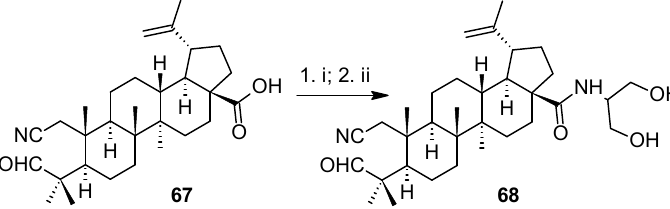
Figure 3. Ionic derivatives of betulinic acid ( 1 ) with antiviral activity against herpes simplex virus